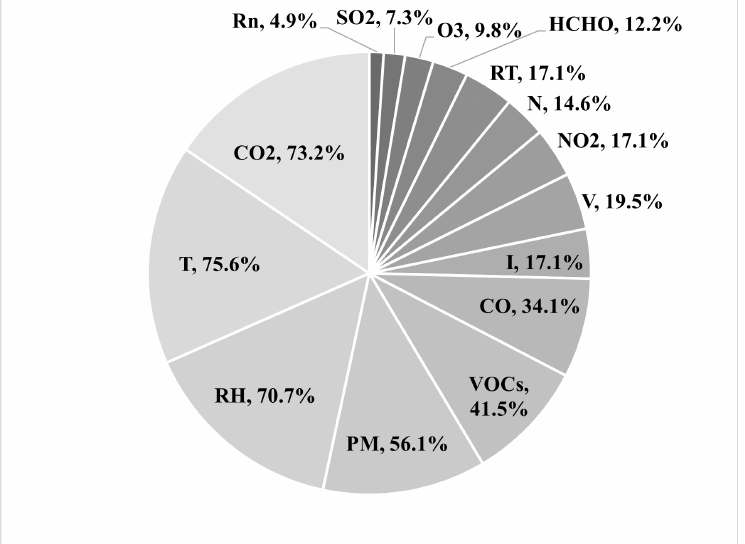
Figure 6. Measured parameter statistics for the selected field measurement studies.